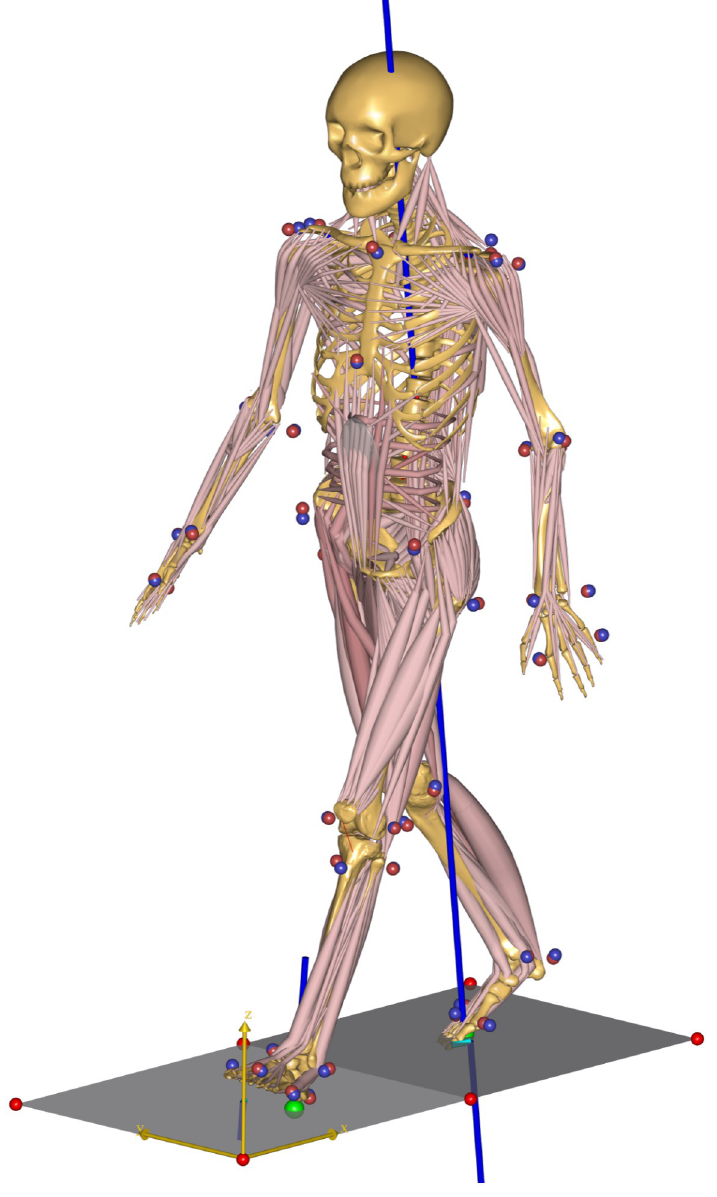
Fig 1. Musculoskeletal model of a walking human. The image captures a frame with both feet in contact with a (different) force plate (i.e., double stance). Muscle elements are shown in pink with skeletal elements in yellow-brown. Some muscles can be adequately represented with a single muscles element (e.g., sartorius) but others (e.g., gluteus medius) require many muscle elements. The location of experimental markers and marker drivers is indicated with red and blue spheres. The force plates are shown in grey and the ground reaction forces in blue, with the length of the line indicative of the magnitude of the force.